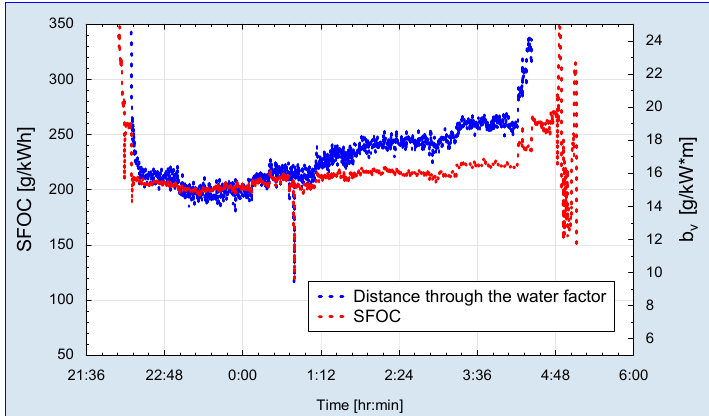
Figure 14. Time record of the specific fuel oil consumption (SFOC).